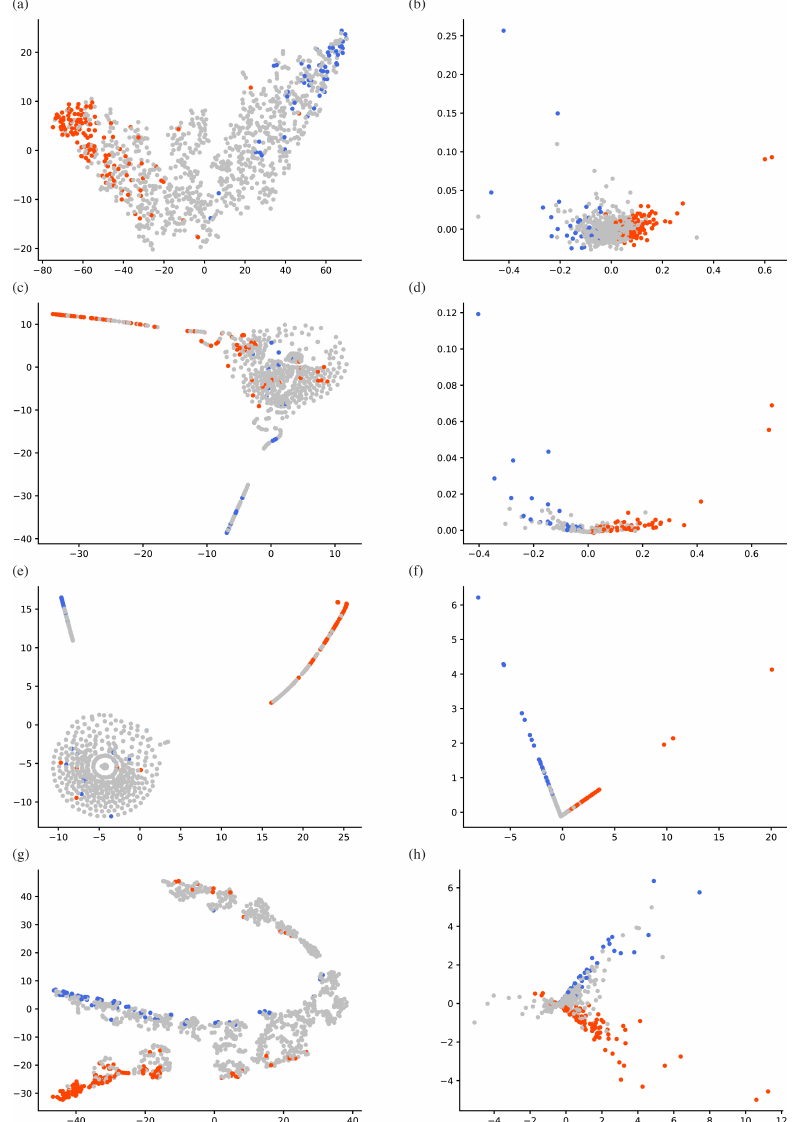
Figure 4. Distribution of hidden representations: ( a ) t-distributed stochastic neighbor embedding (t-SNE) projection for multilayer perceptron (MLP) (baseline), ( b ) principal component analysis (PCA) plot for MLP (baseline), ( c ) t-SNE projection for MLP with element-wise input scaling (EIS) (baseline), ( d ) PCA plot for MLP with EIS (baseline), ( e ) t-SNE projection for Diet Networks ( γ = 0.1), ( f ) PCA plot for Diet Networks ( γ = 0.1), ( g ) t-SNE projection for Diet Networks with EIS ( γ = 0.1), and ( h ) PCA plot for Diet Networks with EIS ( γ = 0.1). Horizontal axis and vertical axis of PCA plots indicate the first and second principal components, respectively. Lung adenocarcinoma (LUAD)-dominant genes and lung squamous cell carcinoma (LUSC)-dominant genes are colored red and blue,